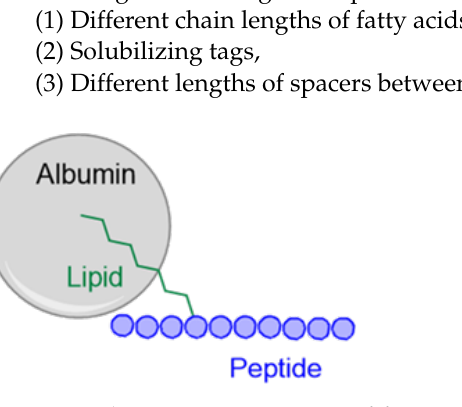
Figure 1. Schematic representation of fatty acid interacting with albumin. Lipid interacts non-covalently to albumin.